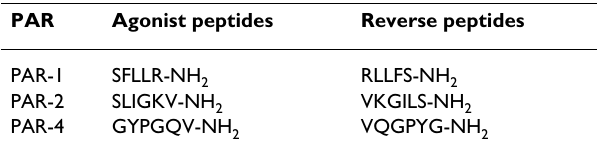
Table 3: Agonist peptides and reverse peptides of PARs used in the study PAR Agonist peptides Reverse peptides PAR-1 SFLLR-NH